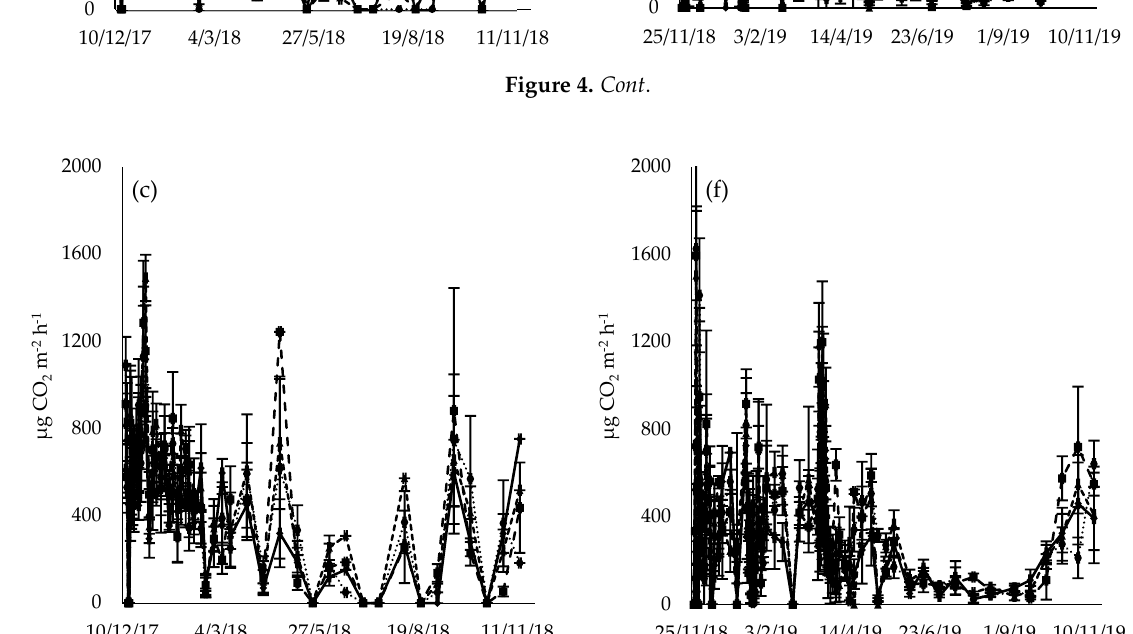
Atmosphere 2021 , 12 , x FOR PEER REVIEW